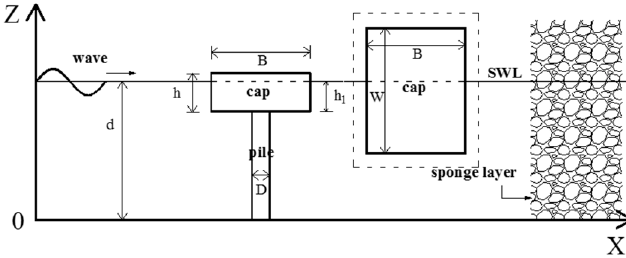
Figure 1. Sketch of the wave and pile-cap system interaction.